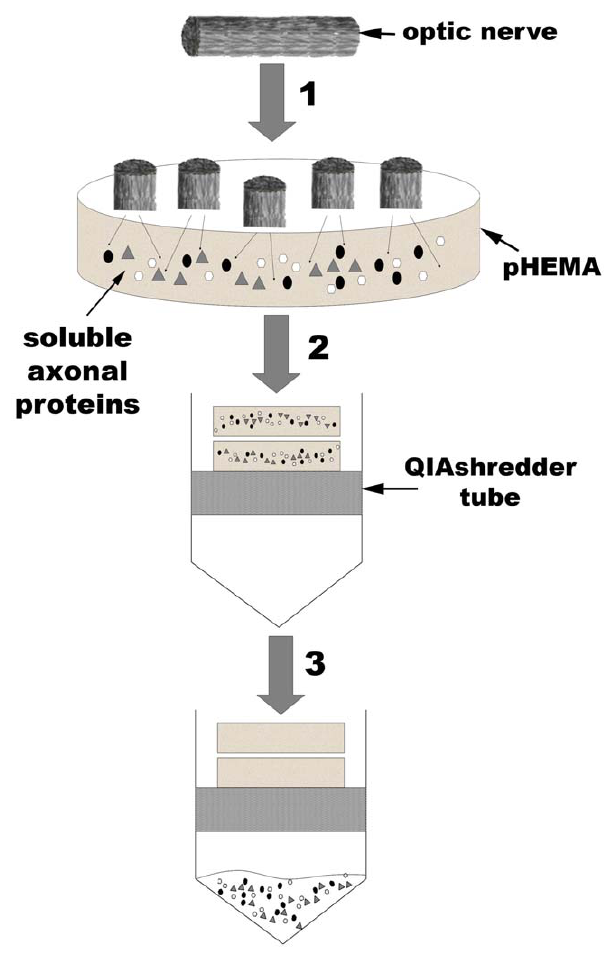
Figure 1. Generation of axoplasm-enriched optic nerve sam- ples using a detergent-free method. (1) Dissected optic nerve is cut into < 1 mm segments and positioned so that axon orientation is at 90 degrees to the pHEMA disk; optic nerve segments are incubated on the pHEMA disks for 1 hr at 4C. (2) Tissue is removed and two pHEMA disks are placed into a QIAshredder tube, overlaid with 80 ul of axoplasm buffer (0.5 M TEAB + protease inhibitor) and incubated at 4C for 10 min. Tubes are then spun at 12,000 g for 10 min, followed by the addition of a further 50 ul of axoplasm buffer, a 5 min incubation at 4C and a further spin at 12,000 g. (3) Axoplasm-enriched samples are collected and placed at 2 20C for storage.